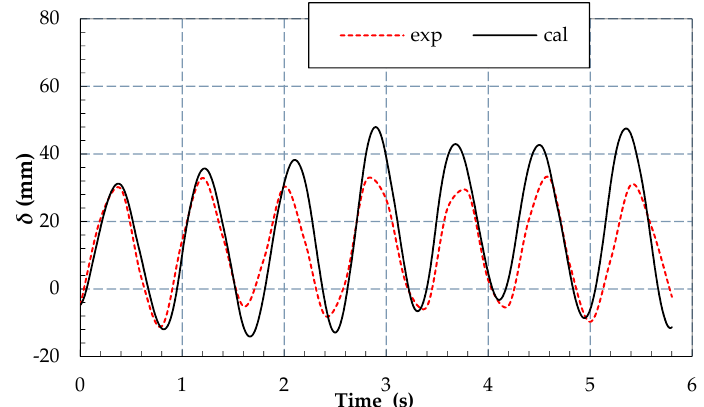
Water 2019 , 11 , x FOR PEER REVIEW Figure 22. Cycle oscillation heave contrast curves for the operation condition of λ = 7 m, F n = 0.99.